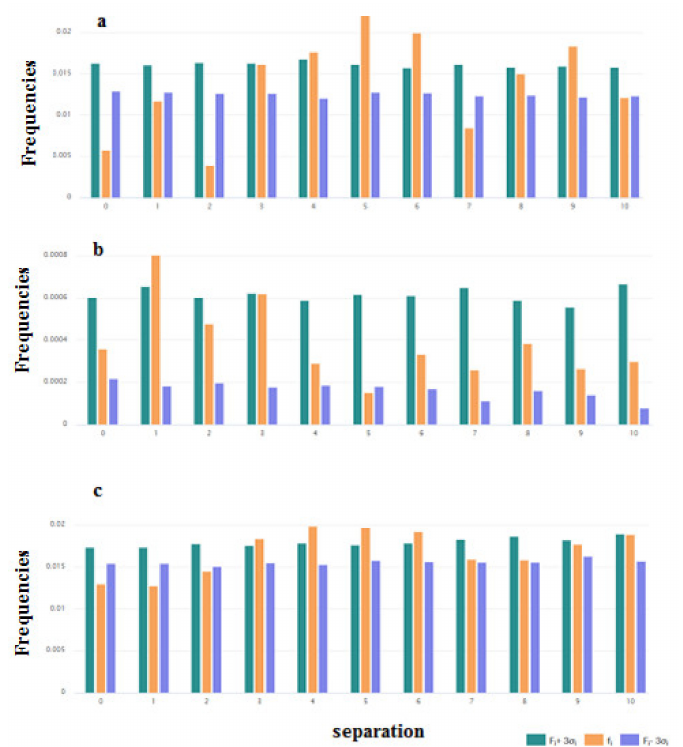
Figure 4. Frequencies of the appearance of pairs of amino acid with the i residues between them, for: ( a ) Cys (C) in the disulfide-bonded ribosomal AMPs set; ( b ) Trp (W) in the full set of ribosomal AMPs; ( c ) Gly (G) in the full set of ribosomal AMPs; The assessments have been performed using the tools of the page of “Statistics” (https://dbaasp.org/statistics, accessed on 20 March 2021) of the DBAASP [17].